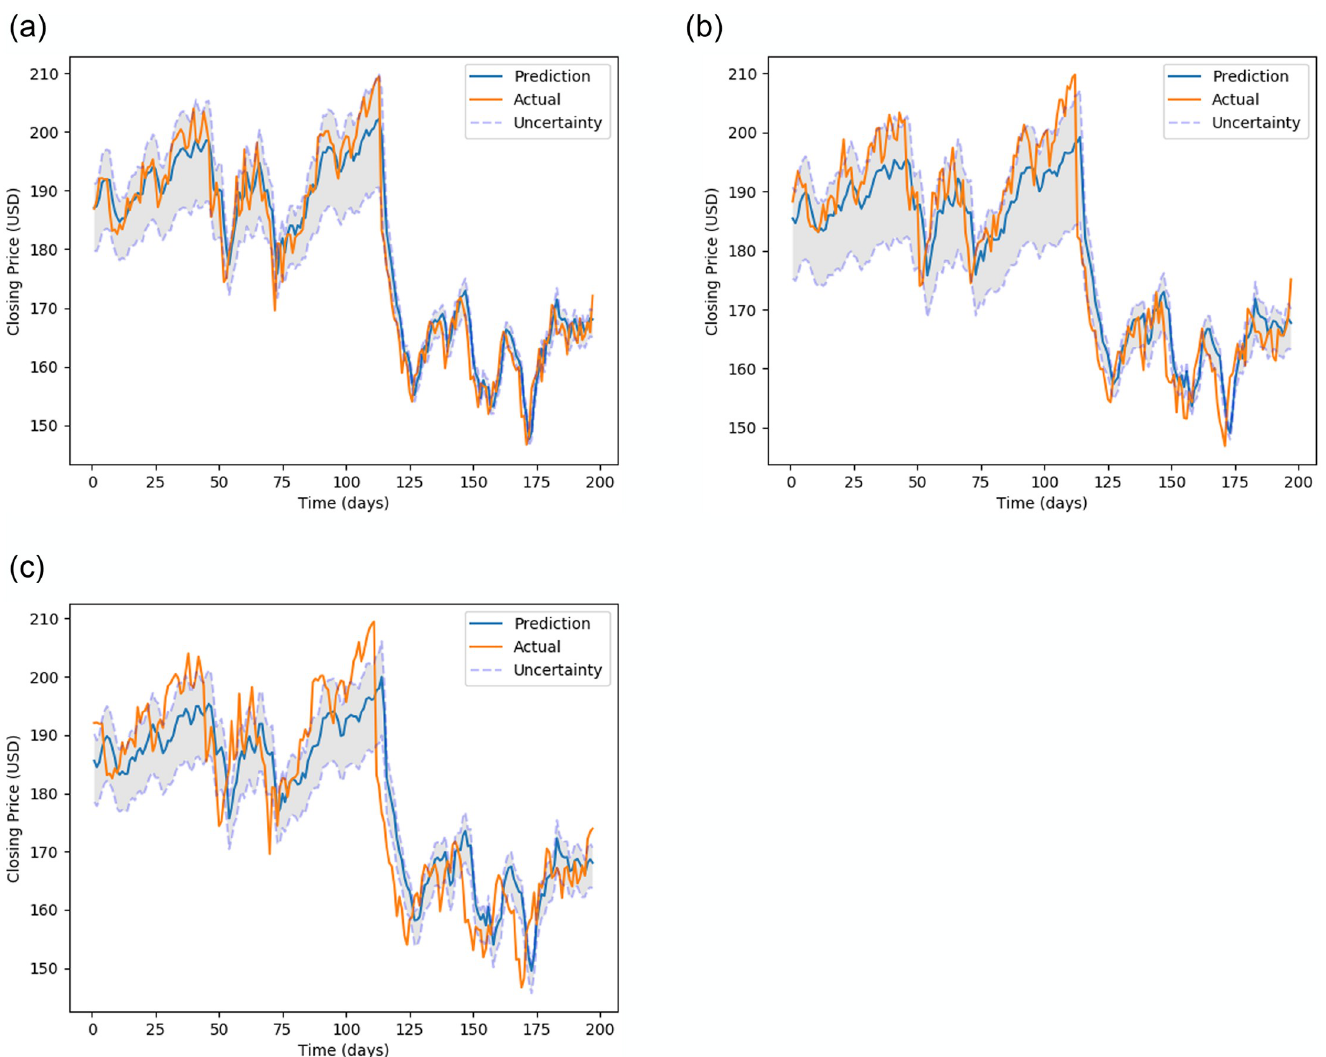
Fig 5. Prediction and uncertainty (shaded region) for test data of stock